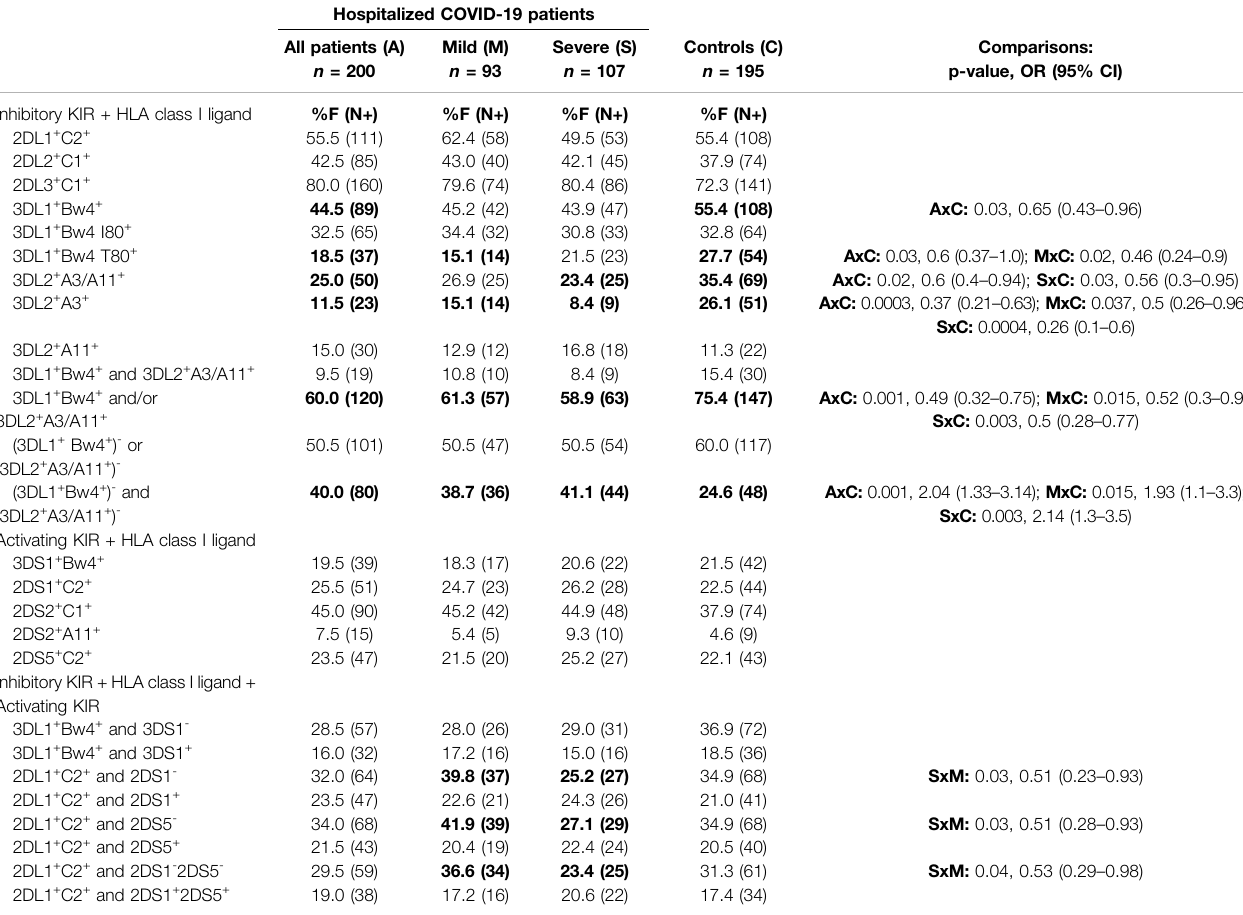
TABLE 3 | Frequency of KIR and HLA class I ligand combination in the control group and COVID-19 patients. Hospitalized COVID-19 patients All patients (A) n =